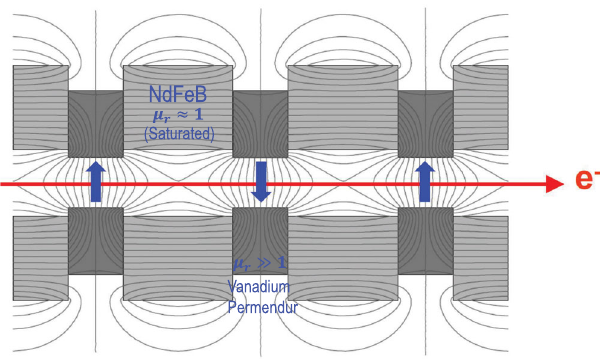
FIG. 1. Damping wiggler chamber cross section with magnetic gap closed, d dw > t dw þ b dw and t dw ≪ b dw .